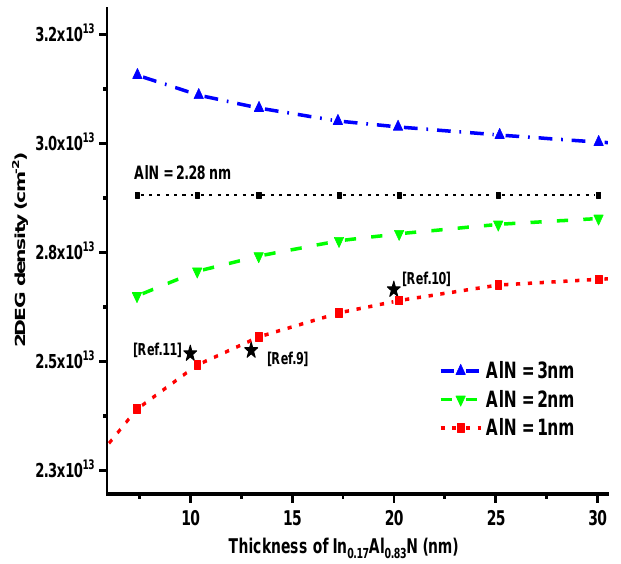
Figure 6. The 2DEG sheet density of In 0.17 Al 0.83 N/AlN/GaN versus InAlN barrier thickness with different AlN thicknesses, The obtained experimental data from [9–11] are given for comparison.